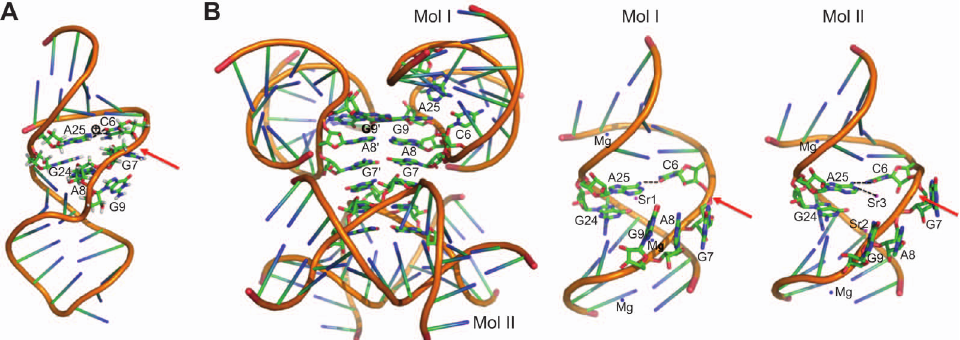
Figure 3 High-resolution structural models of leadzyme. (A) NMR solution structure of leadzyme. Only the active site residues are shown as stick models. The protonated base pair A25H q -C6 is indicated. (B) Crystal structures of leadzyme showing (left) crystal packing among the four molecules in asymmetric unit; (middle) Mol I; and (right) Mol II. Metal ions are shown as small spheres. Red arrows indicate the scissile